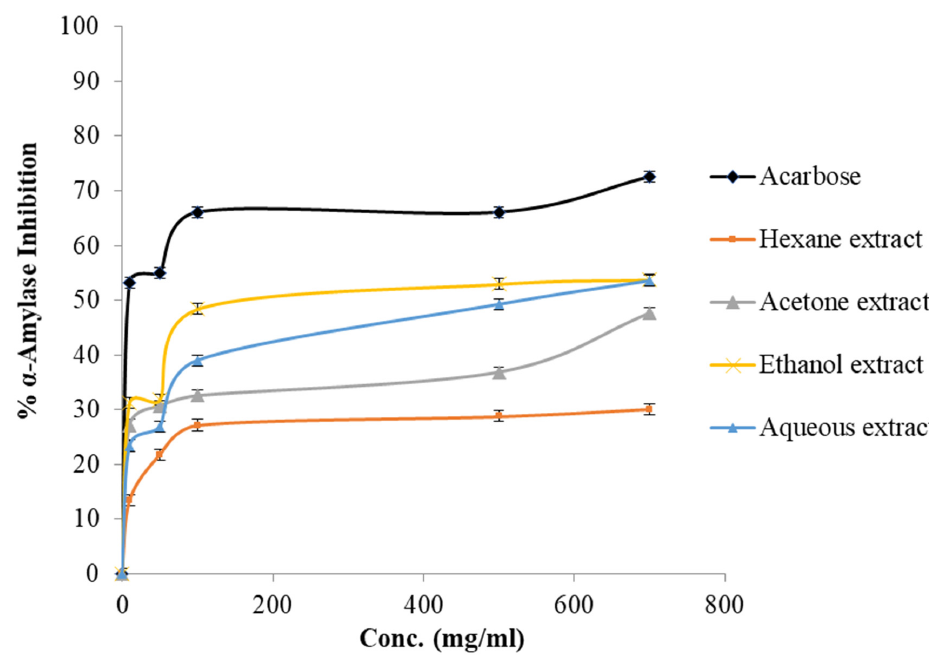
Figure 3. Pancreatic α -amylase inhibitory effect by Artemisia scoparia four extracts and Acarbose. Values are the mean ± SD of triplicate experiments ( p -value < 0.05).